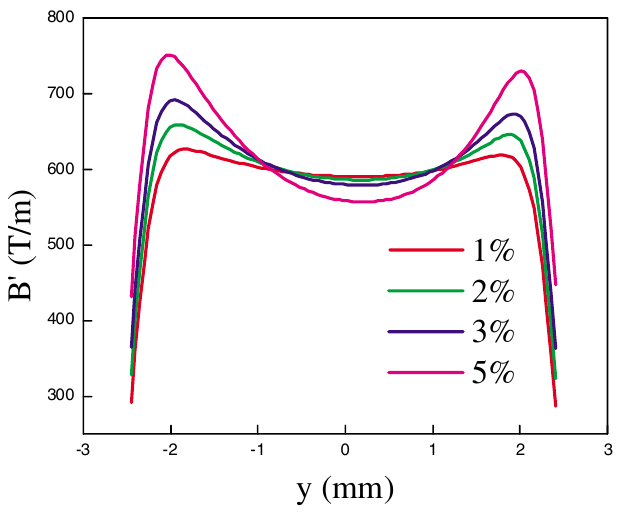
FIG. 4. (Color) Field gradient dependence on magnetization orientation errors.